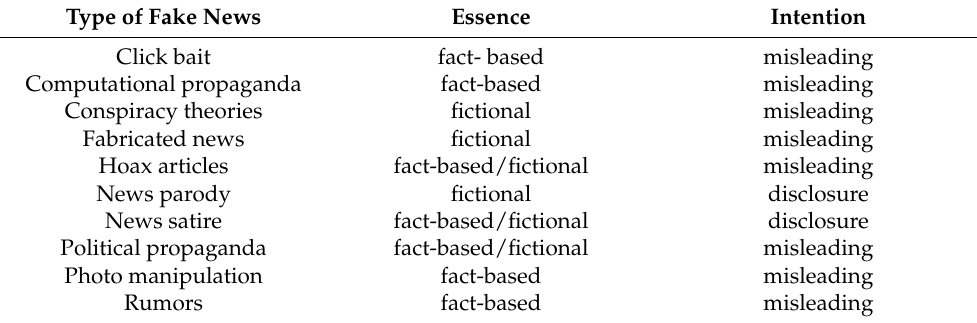
Table 1. Classification of fake news